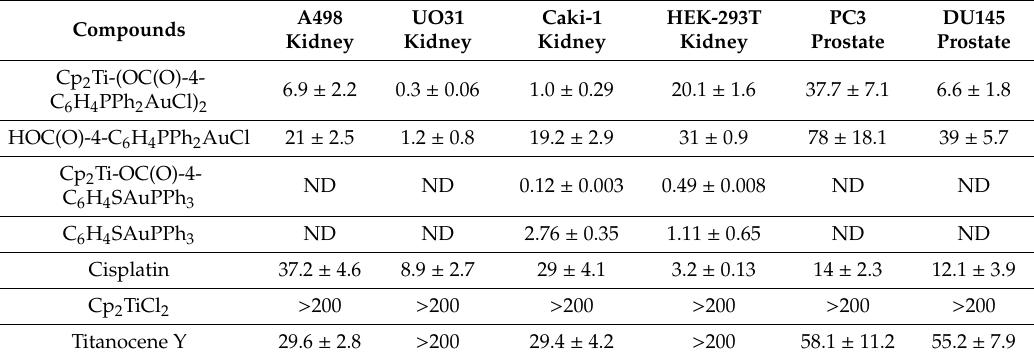
Table 2. Antiproliferative activities ( µ M ± SD) of Ti(IV)–Au(I) complexes against cancer cell